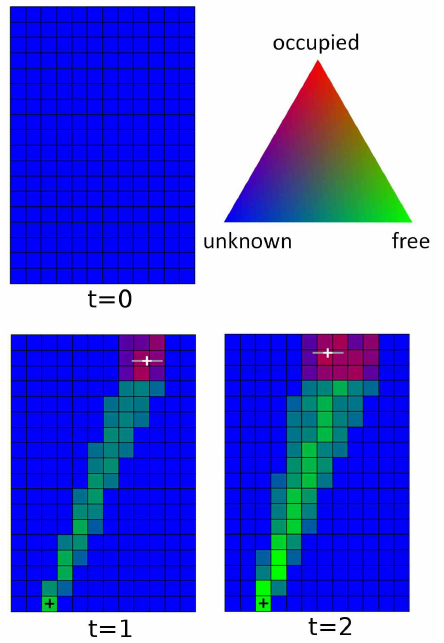
Figure 4: Example of the time recursive update step: At t = 0 , the map is initialized as unknown (dark blue). At time step t = 1 the integration of one Stixel into the map is shown. The cell which is directly hit is red, the immediate cell neighbors are purple. The field of view between ego position (black cross) and the Stixel position is free space which is encoded with the color green. With an additional Stixel measurement at time step t = 2 history and current measurements are merged. The stronger the color saturation the stronger the evidence of free , occupied or unknown